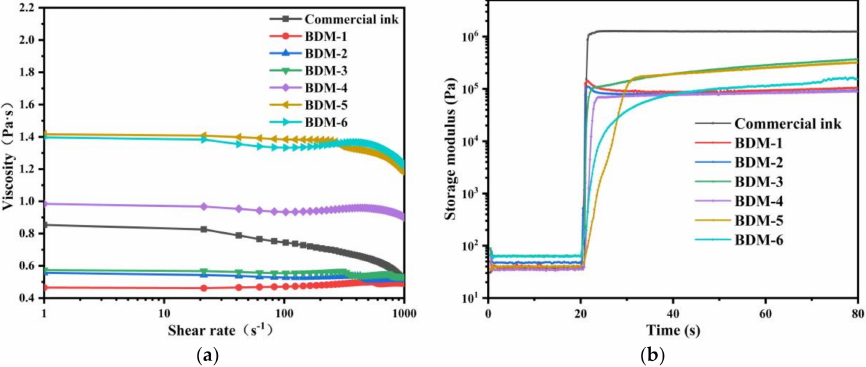
Figure 2. ( a ) Viscosity of BDM inks and commercial ink, and ( b ) influence of BDM-DDM-GMA on the kinetics of UV curing